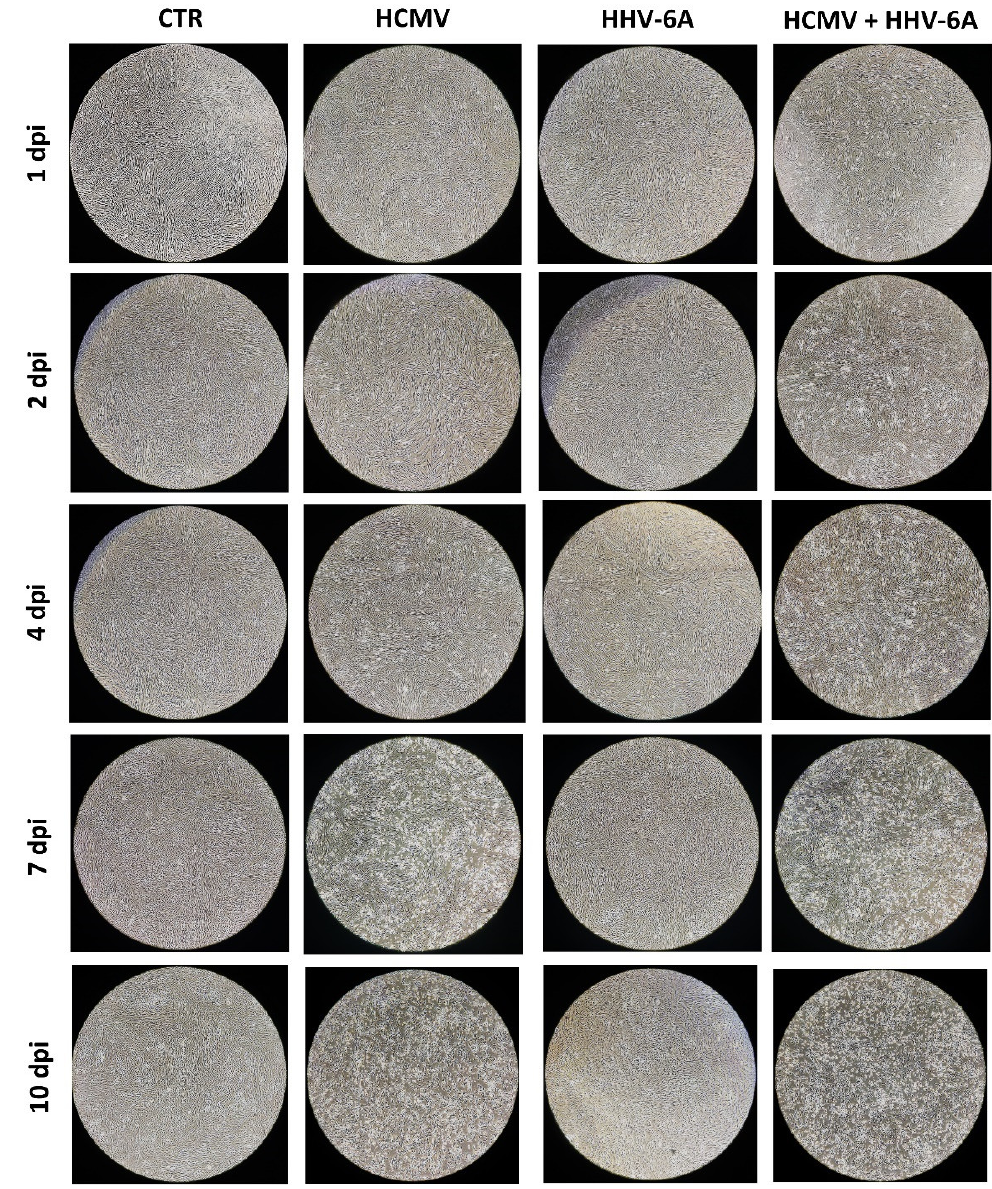
Figure 1. Primary human dermal fibroblasts infected with HCMV and HHV-6A. Images were ac- quired with a phase-contrast microscope at 4X original magnification, and are representative of sample duplicates in two independent